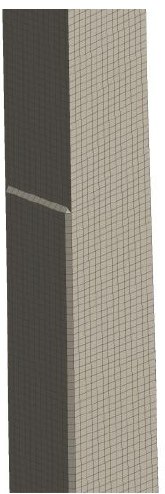
Figure 6. Finite element model of the stanchion: view of the socket.